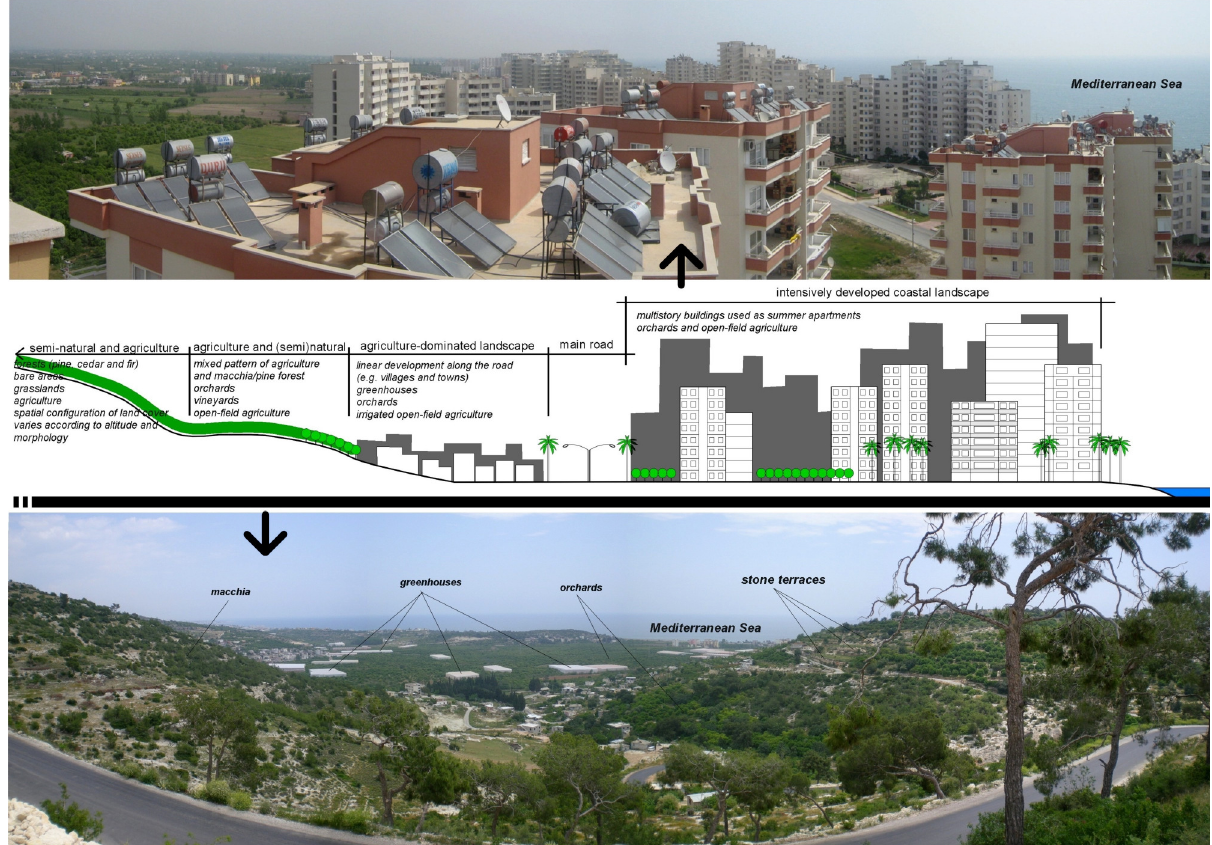
Fig. 5. Typical profile of lower altitudes in the study area. Intensive development along the coastline (above) and the mixed pattern of agriculture areas and (semi) natural vegetation behind the developed coastal zone